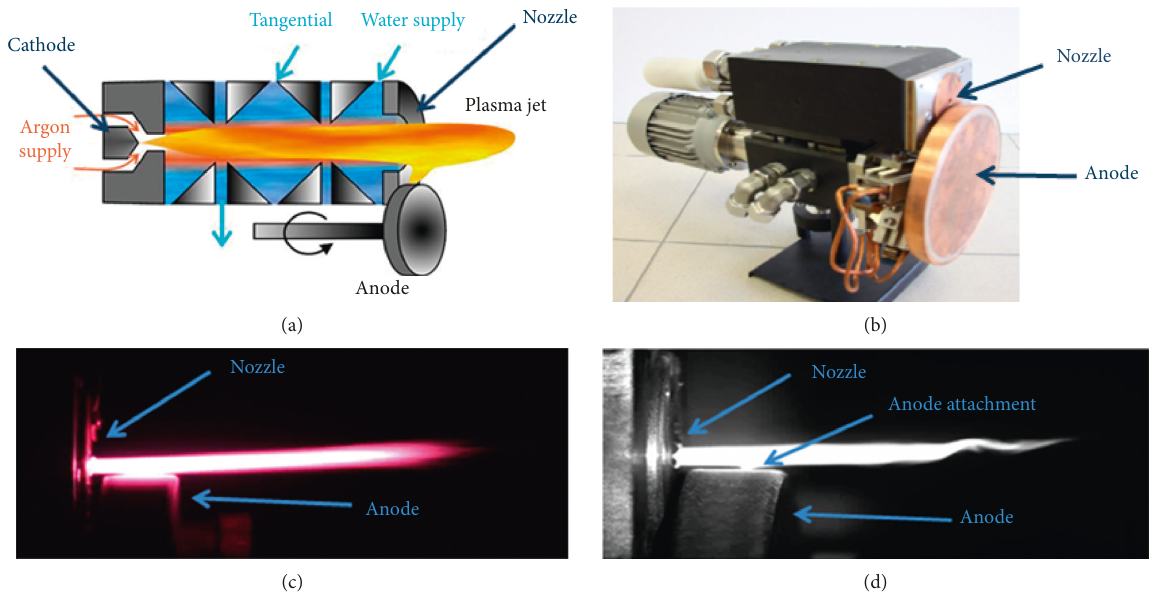
Figure 1: Water-argon plasma torch and jet: (a) schematic view of the torch, (b) photograph of the torch, (c) image of the plasma jet (camera (Canon EOS 450D), exposure time in the order of milliseconds), and (d) image of the plasma jet (high-speed camera (Photron), exposure time in the order of microseconds). Images were taken at the arc current 500 A and argon flow rate